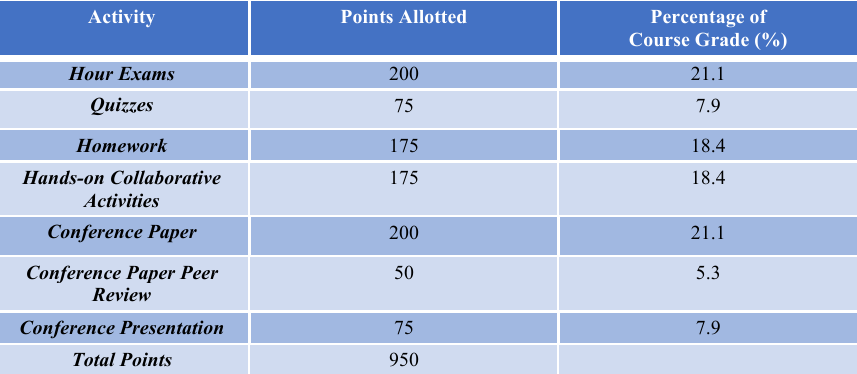
Table 2. Point Distribution for Course Grades